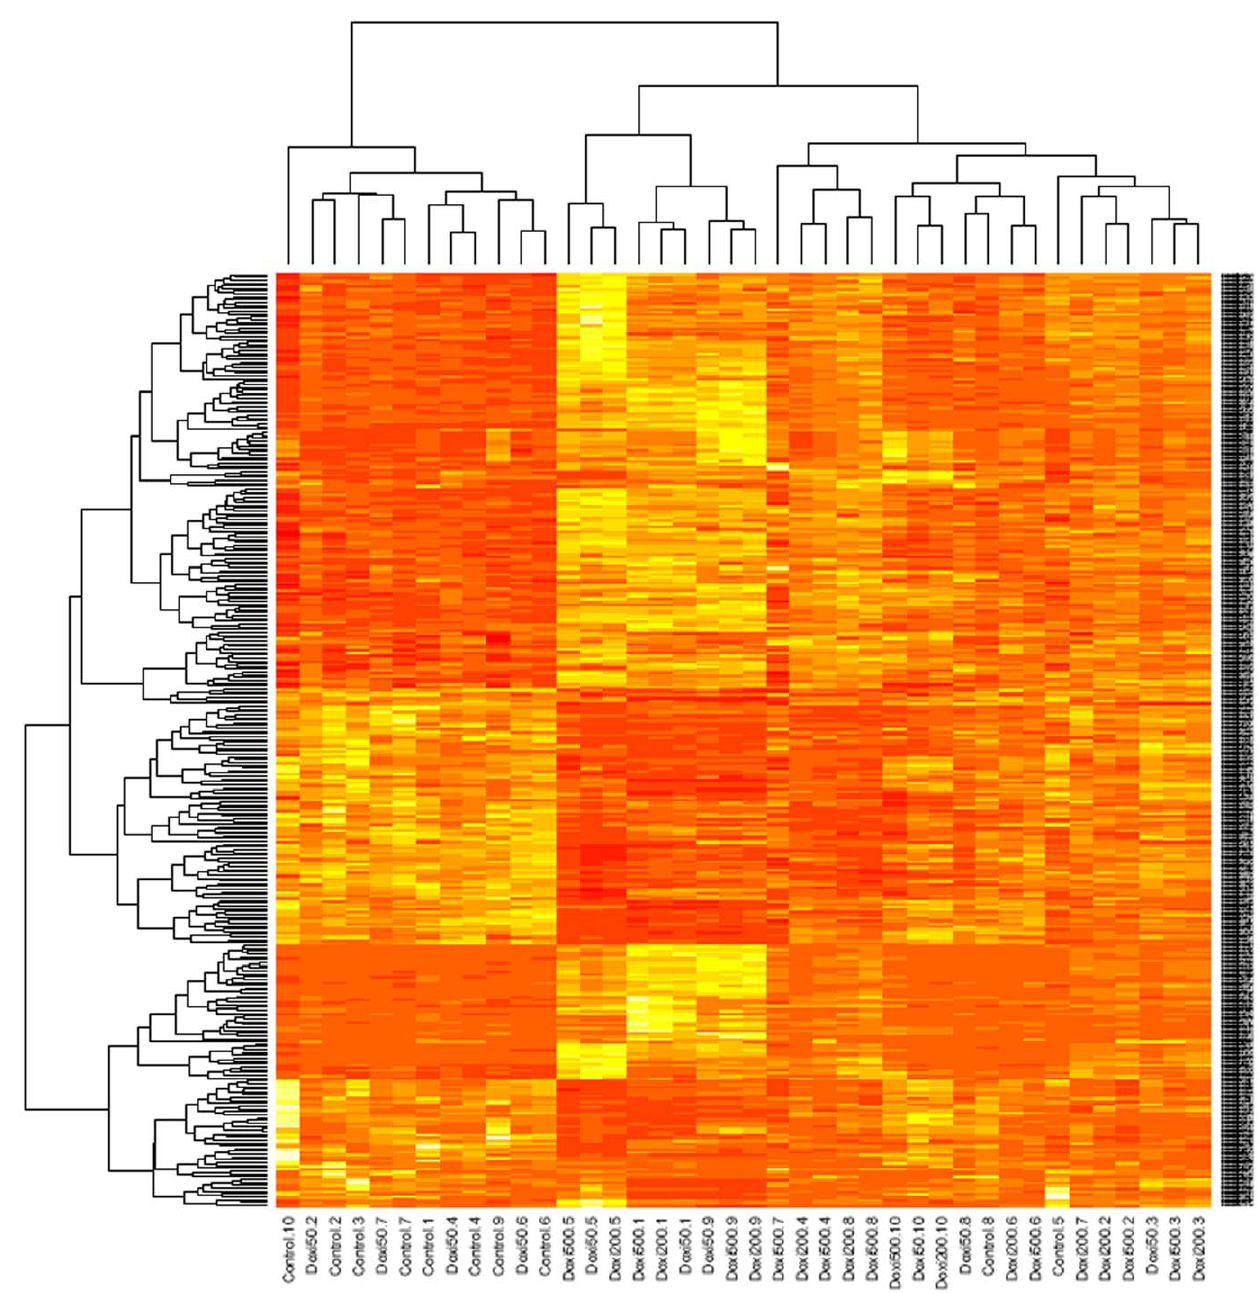
Figure 4. Hierarchical clustering (Manhattan plot) of all samples (columns) and the 332 genes which experienced larger changes upon treatment with doxycycline (lines). All the controls tend to cluster together (left hand side) indicating a good normalization technique. Red color expresses low expression levels and yellow designates high expression levels.